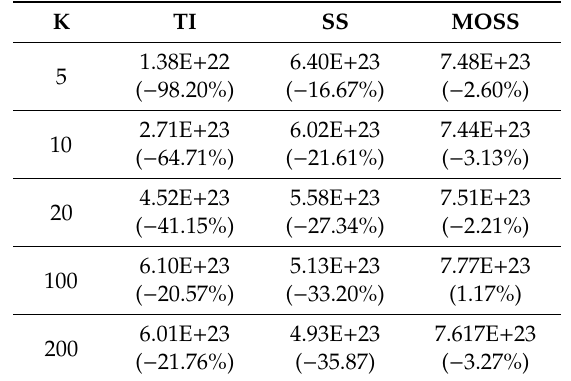
Table 4. BME (BME Relative Error [%]) for ADE2 model using thermodynamic integration (TI), steppingstone sampling (SS), and multiple one-steppingstone sampling (MOSS), for varying sample size n per K interval such that n × K = 2,000,000. The reference BME solution is 7.68 × 10 23 ± 7.34 × 10 21 , and the 95% credible interval of the reference solution error is ± 1.57%.